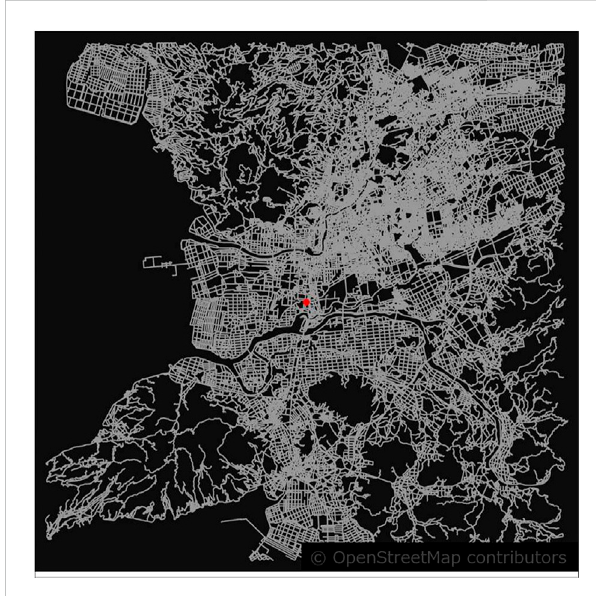
FIGURE 1 Map of 16 km radius around Kawajiri Station (the red dot in the center).